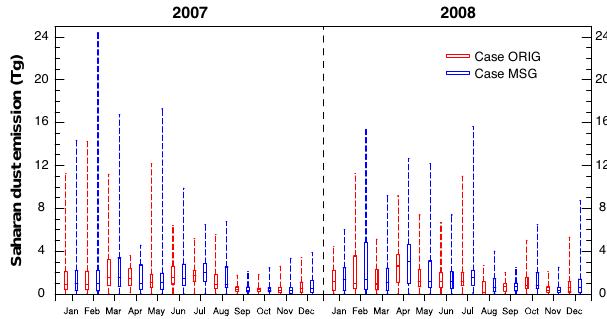
Figure 2. Monthly statistics of daily Saharan dust emissions for 2007 and 2008, computed by the ECHAM-HAM model with the MSG-based source mask (MSG, blue) and the original setup (ORIG, red). The lines of the boxes show the 25th, 50th (median) and 75th percentiles. Dashed lines indicate the range of values be- tween minimum and